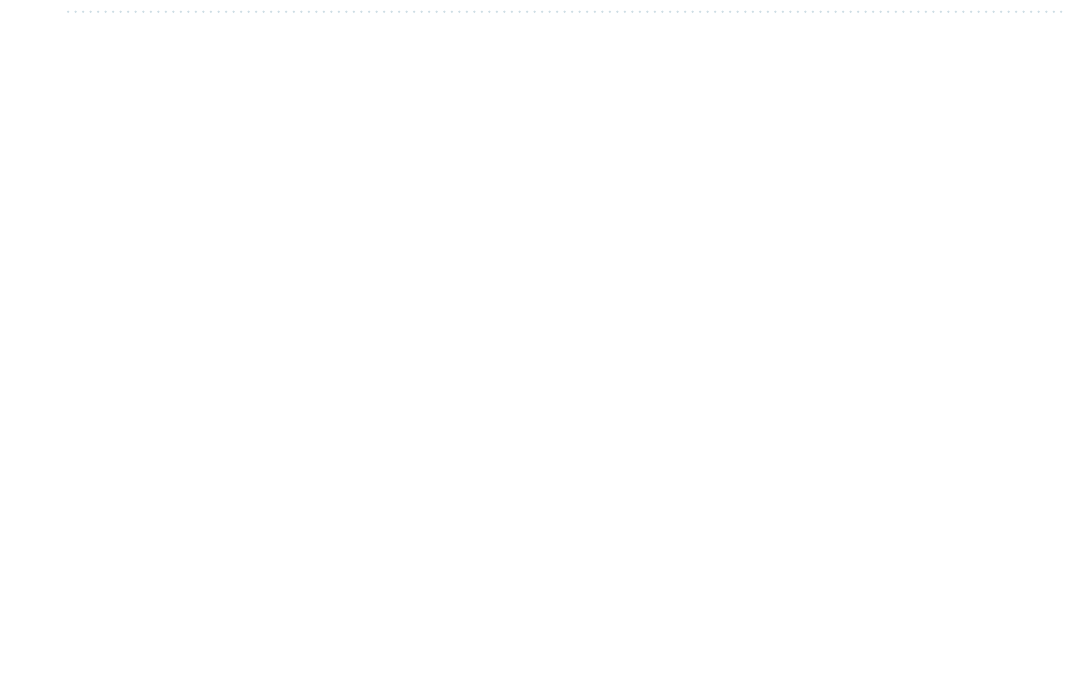
Figure 22. Velocity distribution in ( a ) valve planes and ( b ) valve plane 1 for different intake manifold curve radius at engine speed of 2000